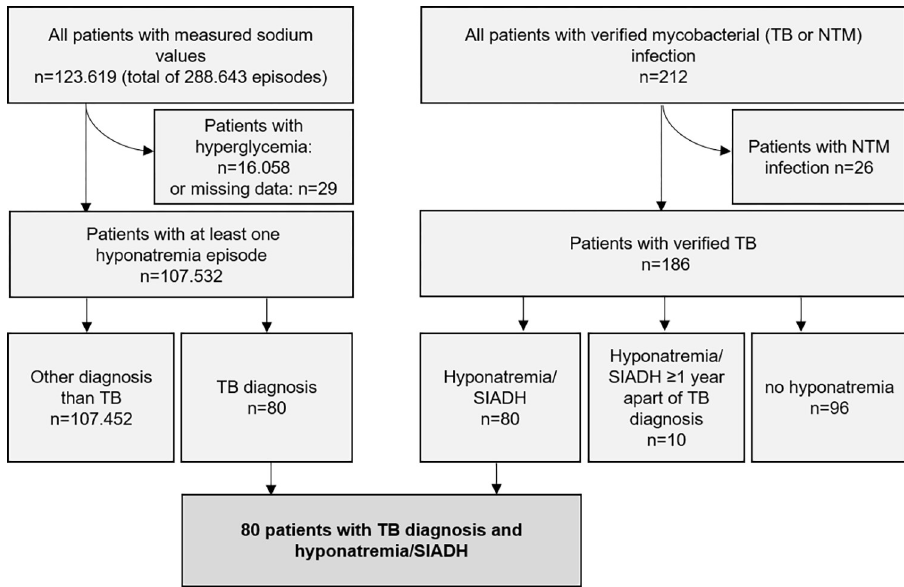
Fig 1. Study cohort. Same-day serum osmolarity < 275 mOsm/kg, urine osmolarity > 100 mOsm/kg, and urine sodium excretion > 30 mmol/L identified SIADH (1087 of 7055 patients tested satisfied all criteria). Hyponatremia, as noted in the flowchart, excluded hyperglycemia. TB, tuberculosis. SIADH, syndrome of inappropriate antidiuretic hormone secretion.